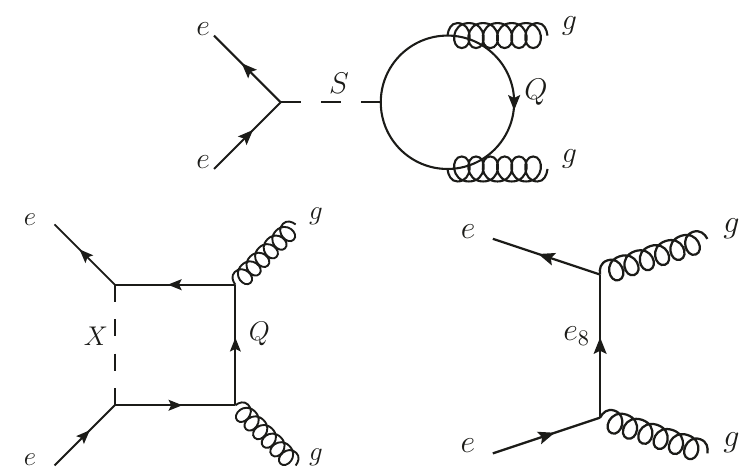
Figure 1 . Generation of e(cid:11)ective electron-gluonic operators in various perturbative UV realizations. Upper panel: scalar-mediated toy model. Lower left panel: leptoquark model. Lower right panel: e 8